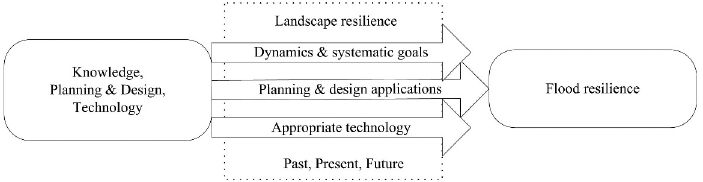
Figure 1. Framework of the technical route from landscape resilience to flooding